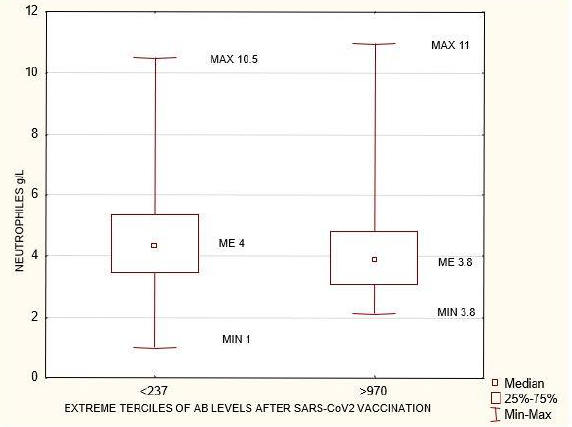
Figure 6. Statistically significant differences in neutrophiles concentration (g/L) between the ex- treme terciles of AB levels after SARS-CoV-2 vaccination <237 AU/mL and >970 AU/mL p = 0.03. Mann – Whitney U test. AB: antibody.